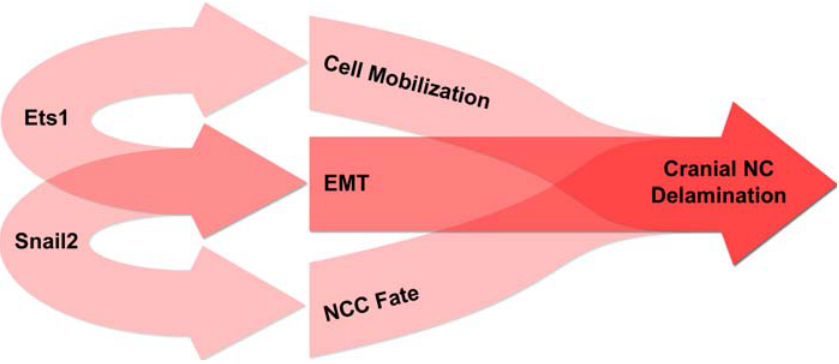
Figure 12. Ets-1 and Snail-2 cooperate to achieve the cranial NCC delamination.